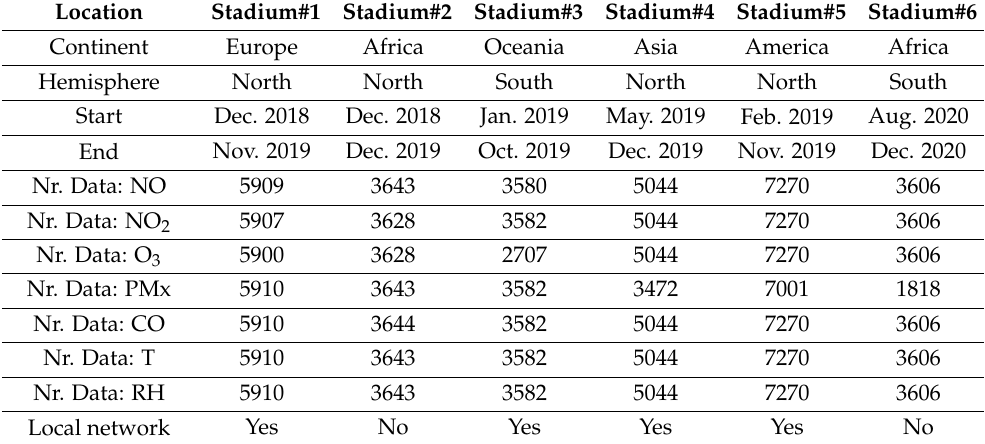
Table 1. Location, monitoring dates and number of valid datapoints (Nr. Data) for each of the air quality monitors deployed. Local network: indicates whether a local air quality network was operational in the